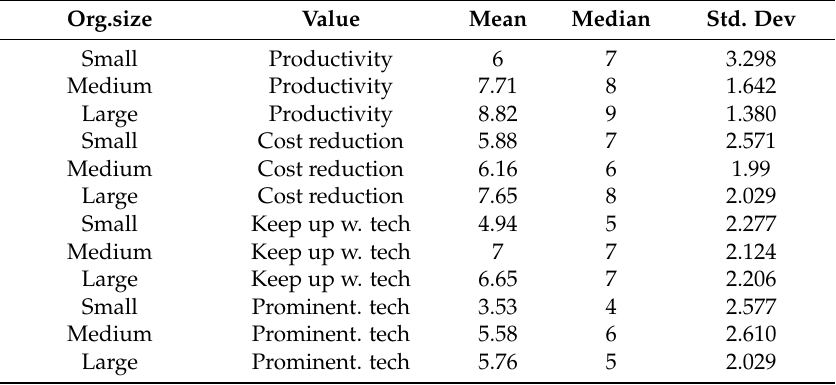
Table 9. Differences based on organization size (national